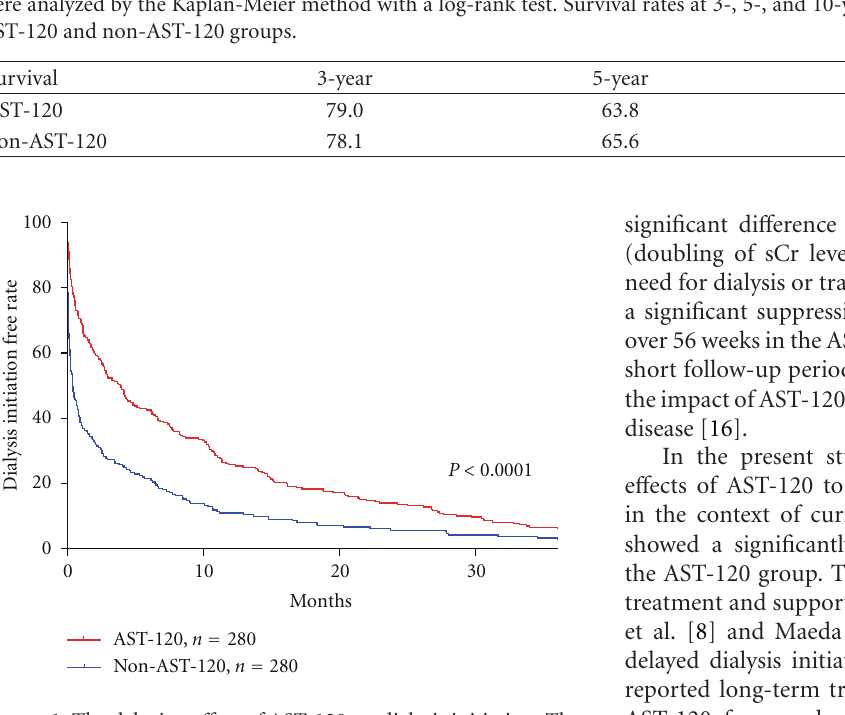
Figure 1: The delaying e ff ect of AST-120 on dialysis initiation. The cumulative percentage of nondialysis patients analyzed by Kaplan- Meier methods showed the delaying e ff ect of AST-120. The dialysis initiation free rate was significantly higher in the pair matched patients receiving AST-120 (AST-120 group, n = 280) compared to those not receiving AST-120 (non-AST-120 group, n = 280) ( P < 0 .